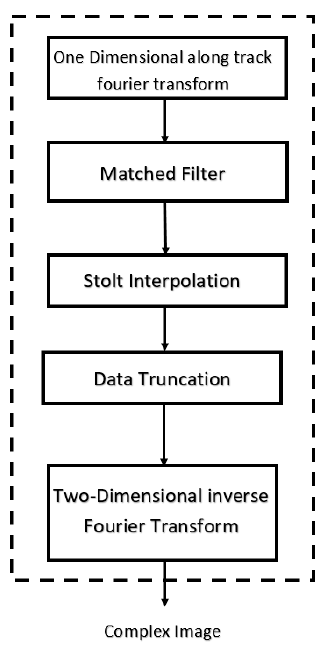
Figure 4. Range migration algorithm block diagram.